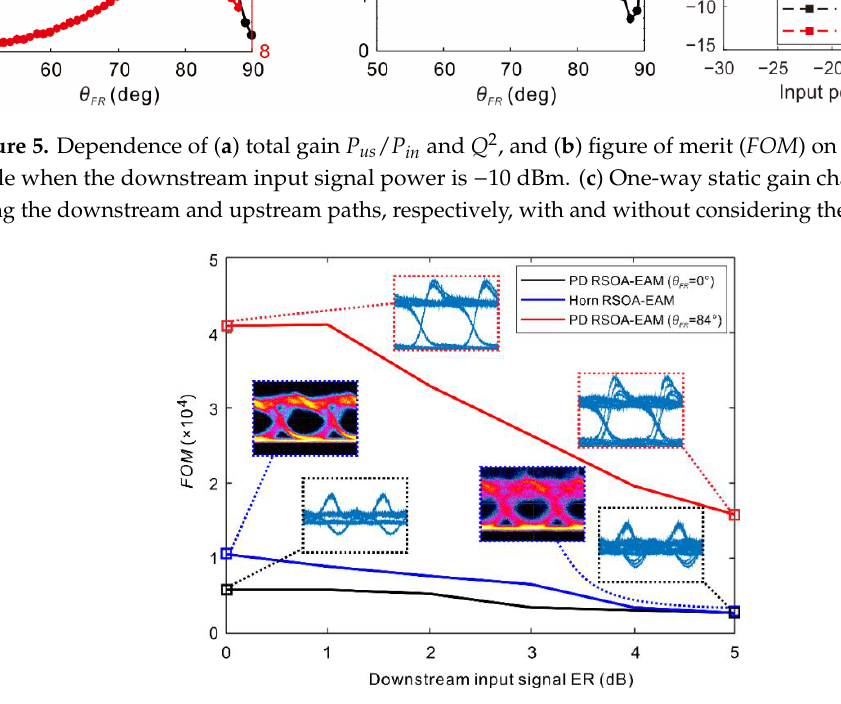
Figure 6. FOM versus the downstream input signal ER of the horn-waveguide RSOA–EAM [22], and of the proposed PD RSOA–EAM at a rotation angle of 0° and 84°. The inlets are the upstream signal eye-diagrams (data rates of the down- and upstream signals: 10 Gbps and 5 Gbps, respectively).